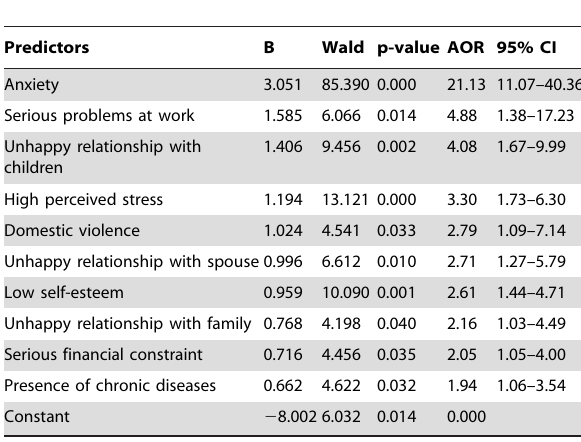
Table 8. Predictors of depression based on multivariate logistic regression analysis.